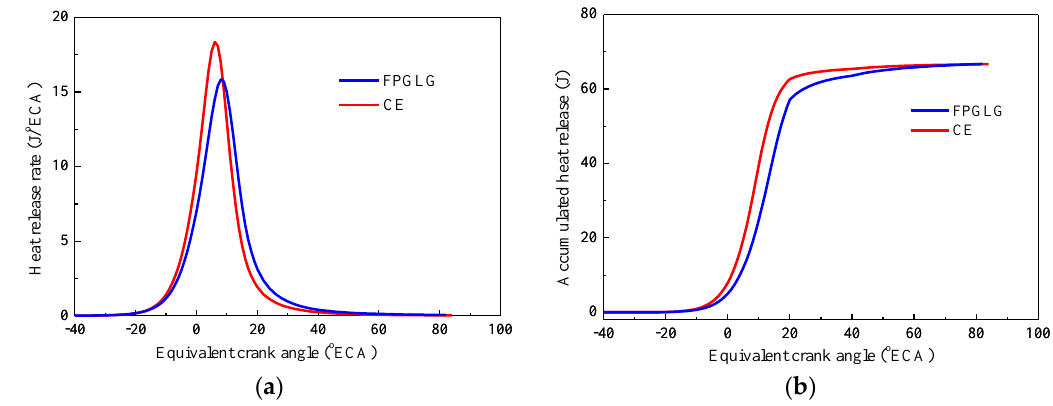
Figure 17. ( a ) Comparison of the heat release rate; ( b ) comparison of the accumulated heat release.